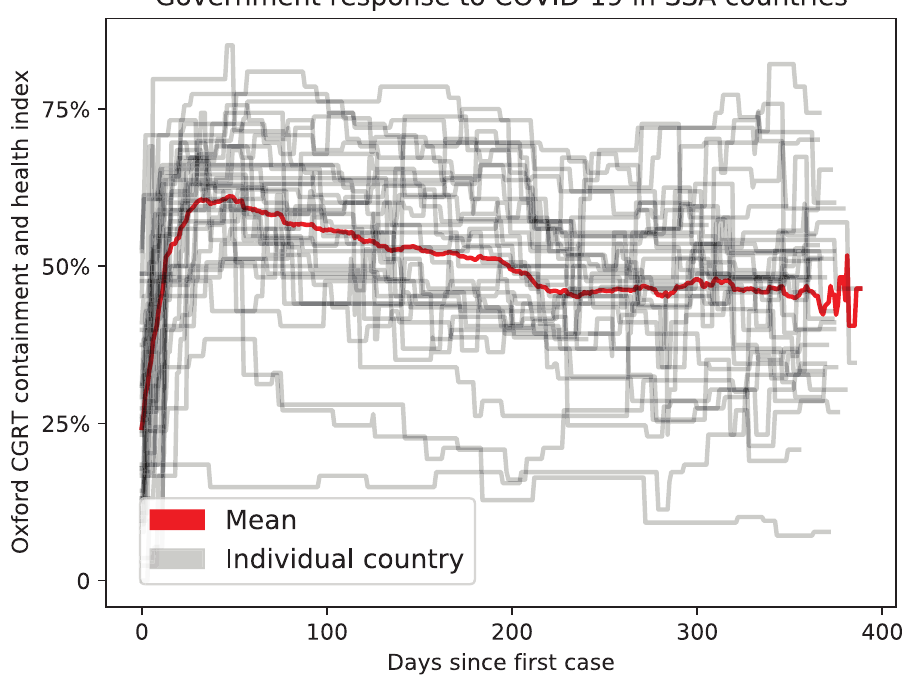
Fig 2. NPI policies as scored by OxCGRT for SSA